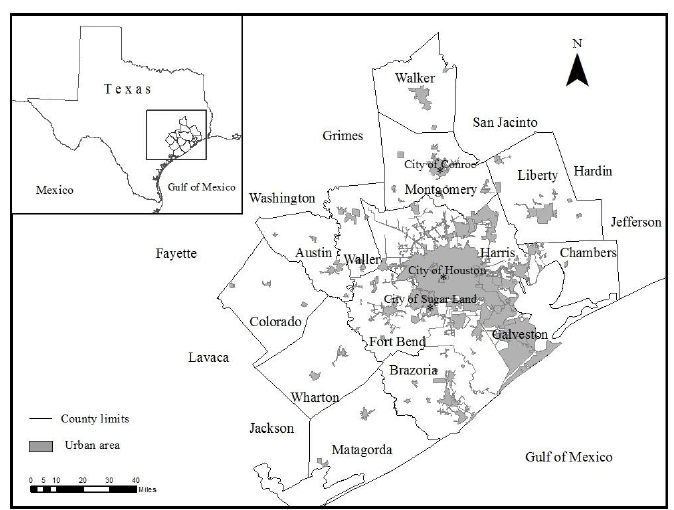
Figure 1: Houston-Galveston Area and its 13